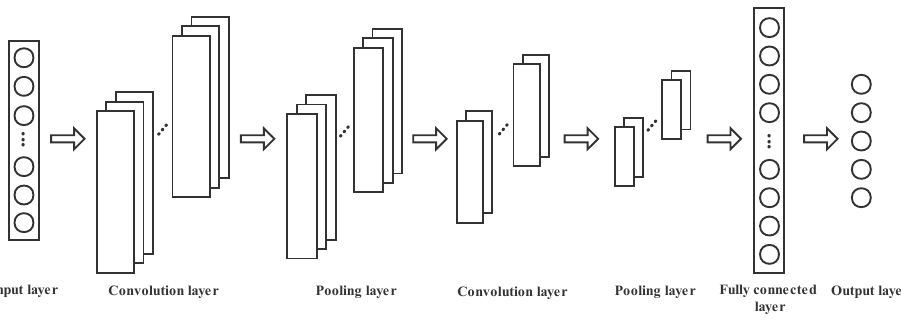
Figure 2. The network structure of the CNN.